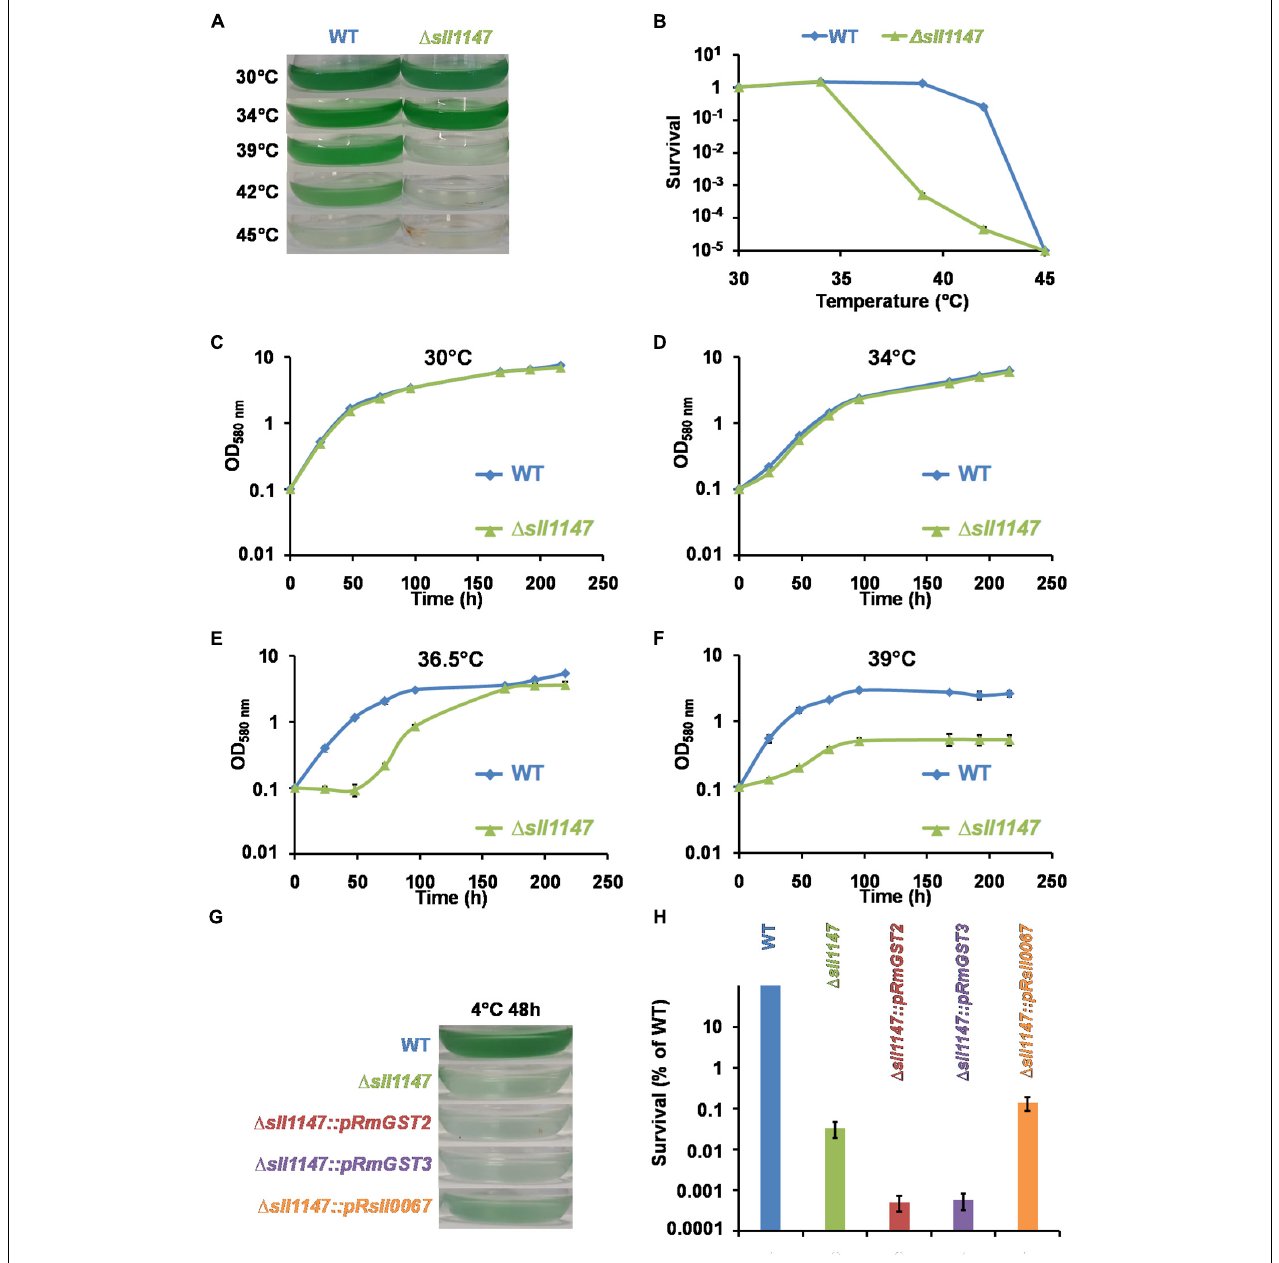
FIGURE 4 | The Sll1147 MAPEG-like GST is involved in the Synechocystis tolerance to high and low temperatures. Ten milliliters of mid-log-phase cultures (initial OD 580 nm = 0.1) were incubated in liquid MM for 24 h under standard light (2500 lux; 31.25 µ E.m - 2 .s − 1 ) at the indicated temperatures, prior to photographing the culture flasks (A) and survival analysis (B) . (C–F) Growth curves of WT and (cid:49) sll1147 strains incubated in liquid MM under standard light (2500 lux; 31.25 µ E.m − 2 .s − 1 ) at various temperatures: 30 ◦ C (C) , 34 ◦ C (D) , 36.5 ◦ C (E) , and 39 ◦ C (F) . (G) Ten milliliters of mid-log-phase cultures (initial OD580nm = 0.1) were incubated in liquid MM for 48 h under standard light (2500 lux; 31.25 µ E.m − 2 .s − 1 ) at 4 ◦ C and then 24 h at 30 ◦ C for recovery, before photographing the culture flasks. (H) Survival of WT strain and (cid:49) sll1147 , (cid:49) sll1147:pRmGST2 , (cid:49) sll1147:pRmGST3 , and (cid:49) sll1147:pRsll0067 mutants exposed for 48 h to 4 ◦ C. Data shown in (B–F,H) are expressed as the mean ± SD of three